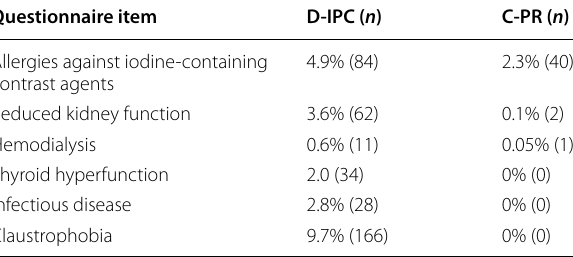
Table 6 Comparison of red-flag prevalence documented with entirely digitized, tablet-based informed patient consent (D-IPC) versus the data documented in the conventional patient records